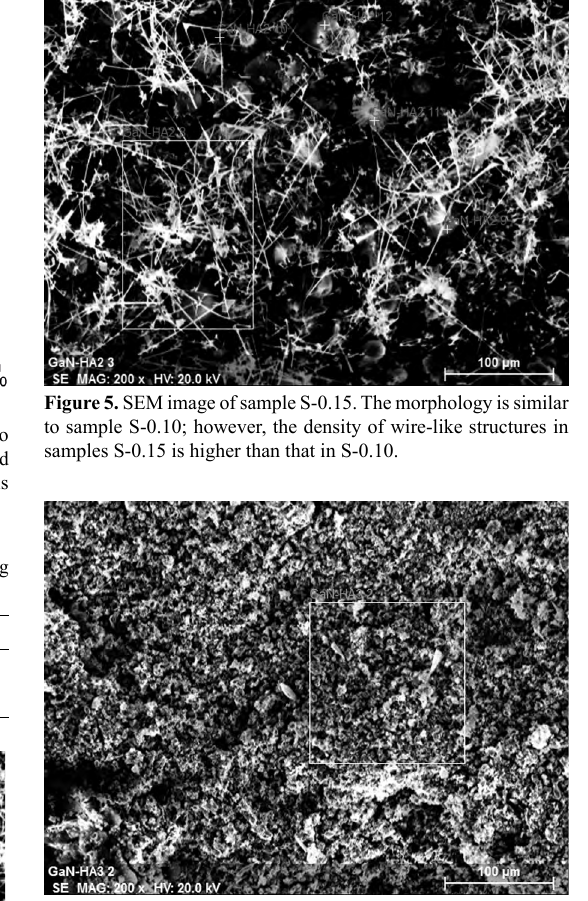
Figure 6. SEM image of sample S-0.20. Morphology of this is completely different, the density of wire-like structures appears to be null compared with samples S-0.10 and